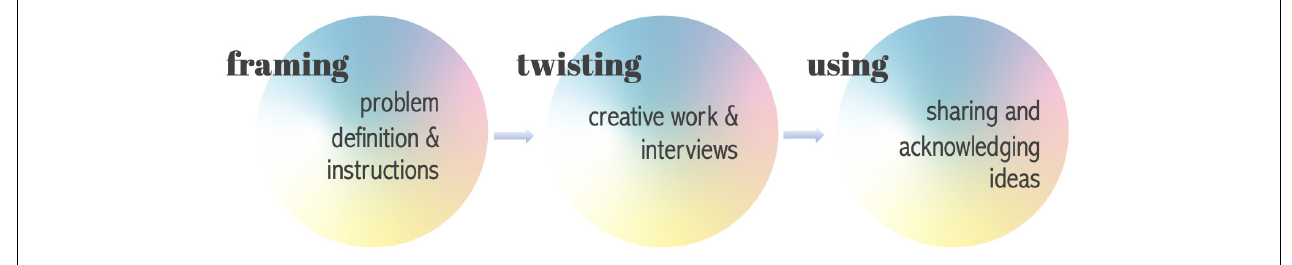
FIGURE 1 | Illustration of the three interdependent steps of the NIYF methodology (by Löfström).